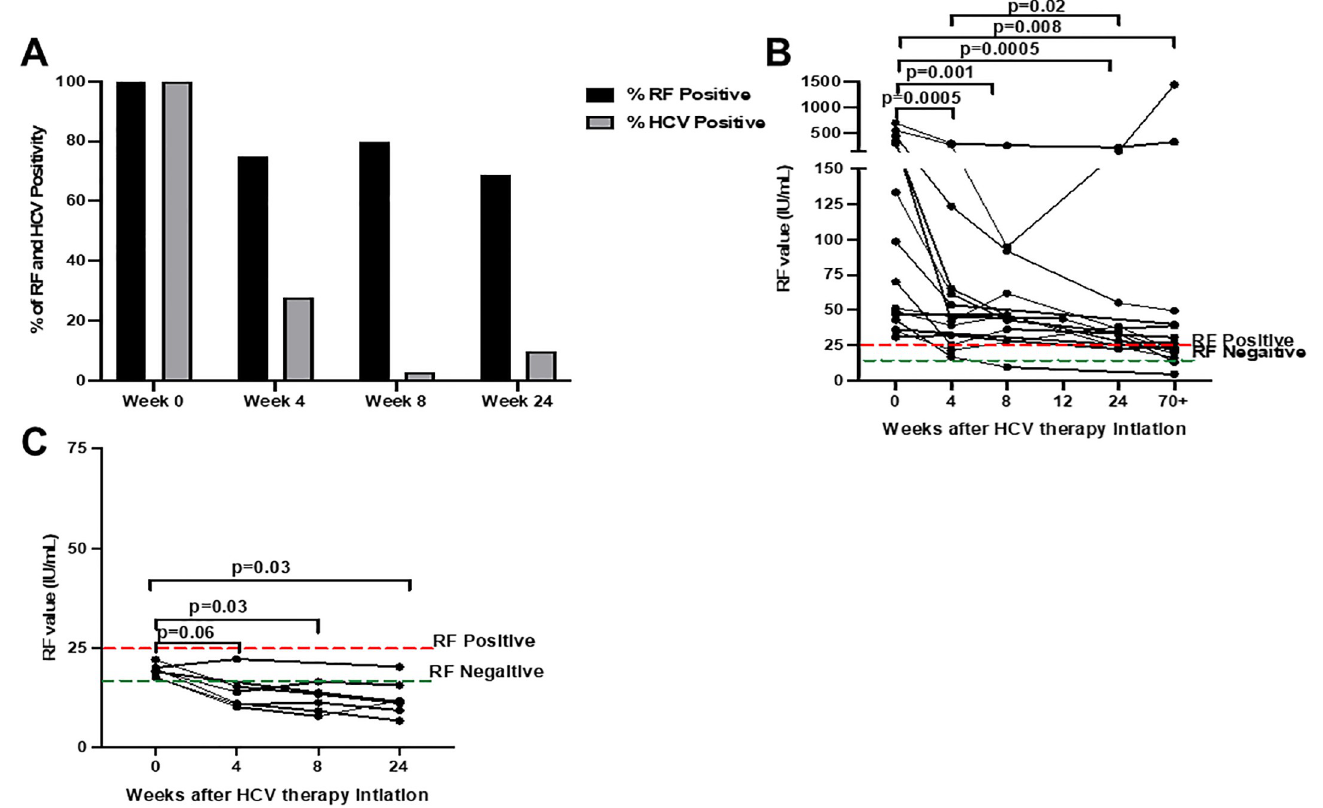
Fig 1. Rheumatoid factor (RF) positivity commonly persists in hepatitis C virus (HCV) infected persons during and after the course of direct-acting antiviral (DAA) therapy. HCV infected (HCV+) RF positive (RF+) persons were followed longitudinally over the course of HCV DAA therapy; before (week = 0: n = 44), during (week 4: RF+ n = 27/36, 75%; HCV+ n = 11/39, 28%), (week 8: RF+ n = 24/30, 80%; HCV+ n = 1/39, 3%) and after (week 24: RF+ n = 18/26, 69%; HCV+ n = 4/39, 10%) treatment, where the proportion of the persons that were RF+ ( > 24 IU/mL) and had detectable serum HCV levels was determined (A) . A subset of this group (week 0, n = 15) was followed over an additional extended time frame after HCV DAA therapy initiation at week 4: RF+ n = 11/13, 85%; week 8: RF+ n = 10/11, 91%; week 12: RF+ n = 1/1, 100%; week 24: RF+ n = 11/13 85%; and at least 70 weeks out (week 74–158): RF+ n = 7/15 47%; and the serum RF values determined at each timepoint (B) . RF intermediate (n = 6, 17–24 IU/mL) (C) persons that were HCV+ was followed up and the serum RF values determined at each timepoint along the course of HCV DAA therapy. Differences between timepoints were determined by the paired Wilcoxon test.